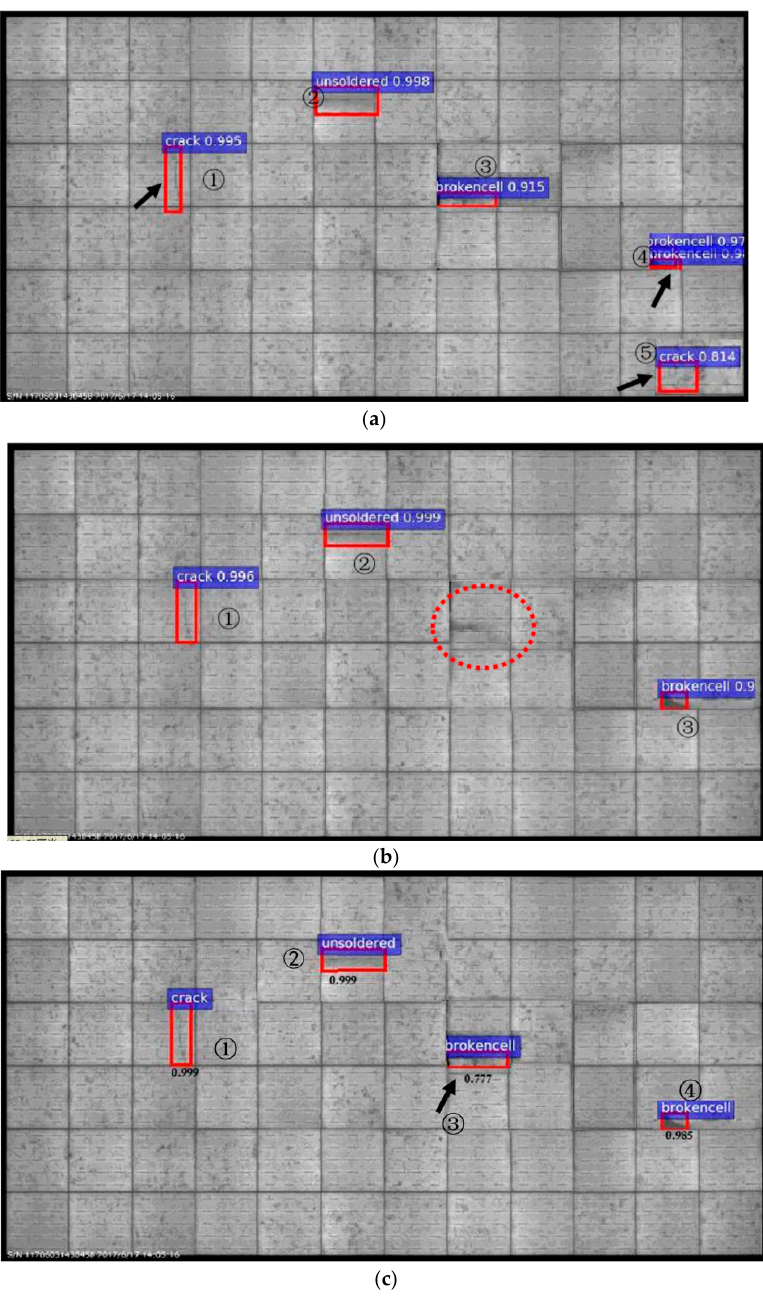
Figure 7. The YOLO v3-tiny, YOLO v3, and this paper’s algorithm are used to detect different defects: ( a ) the YOLO v3-tiny algorithm detection result; ( b ) theYOLO v3 algorithm detection result. As shown in ( c ), this paper improves the algorithm defect-detection result.